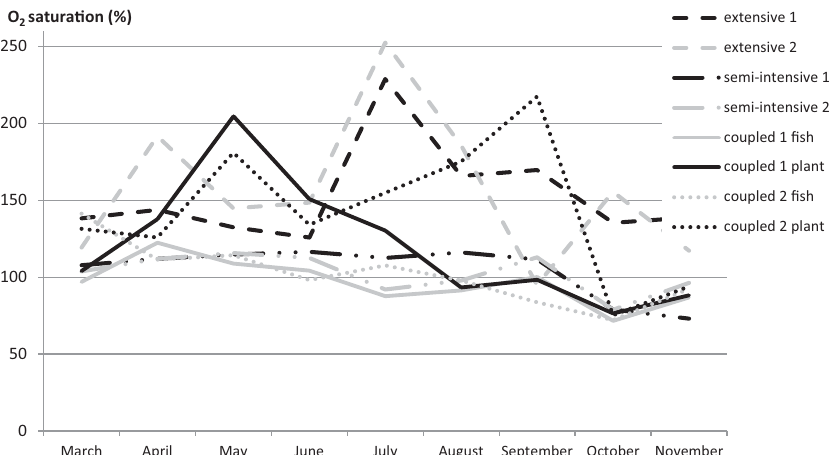
Fig. 4. Water oxygen saturation dynamics during the rearing period in two replicates of carp polyculture ponds: extensive (without formulated feed), semi-intensive (with feed and double fi sh density) and coupled (semi-intensive ( fi sh) þ planted lagoon